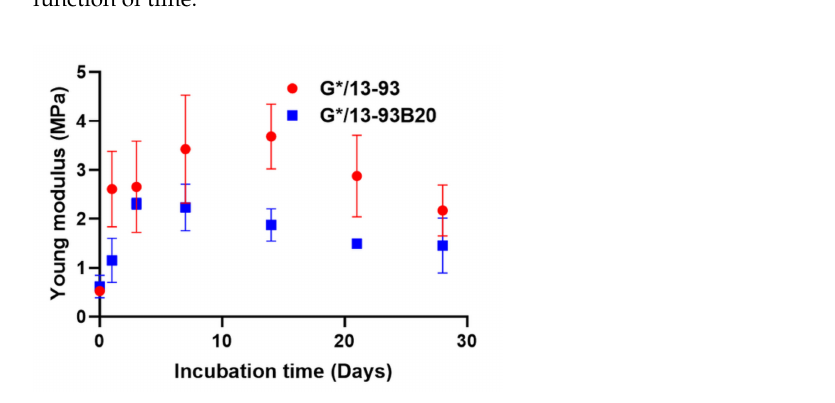
Figure 5. Young’s modulus measured by a compression test of wet G*/13-93 ( • ) and G*/13-93B20 ( (cid:4) ) hybrids as a function of immersion time in